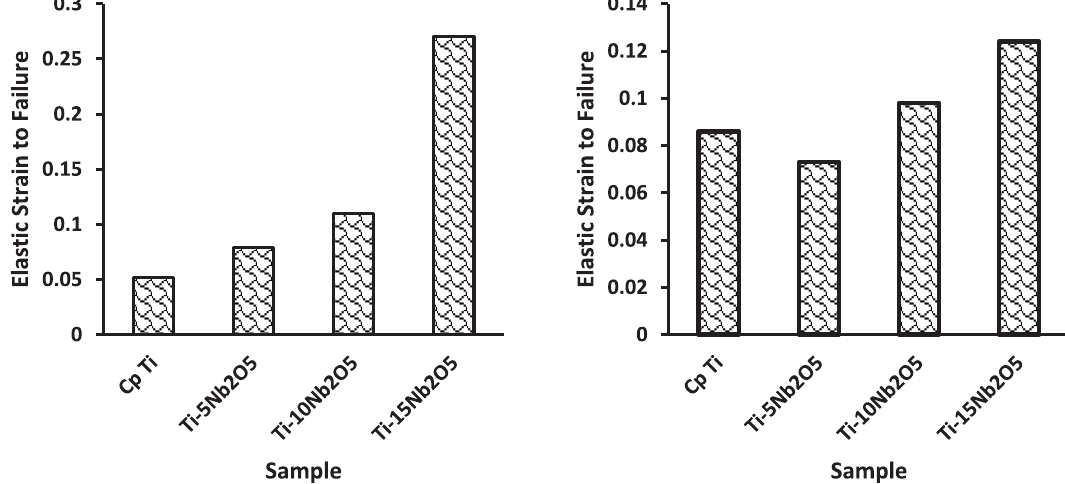
Fig. 9. (a) Resistance to elastic strain at 20mN (b Resistance to elastic strain at 100mN.